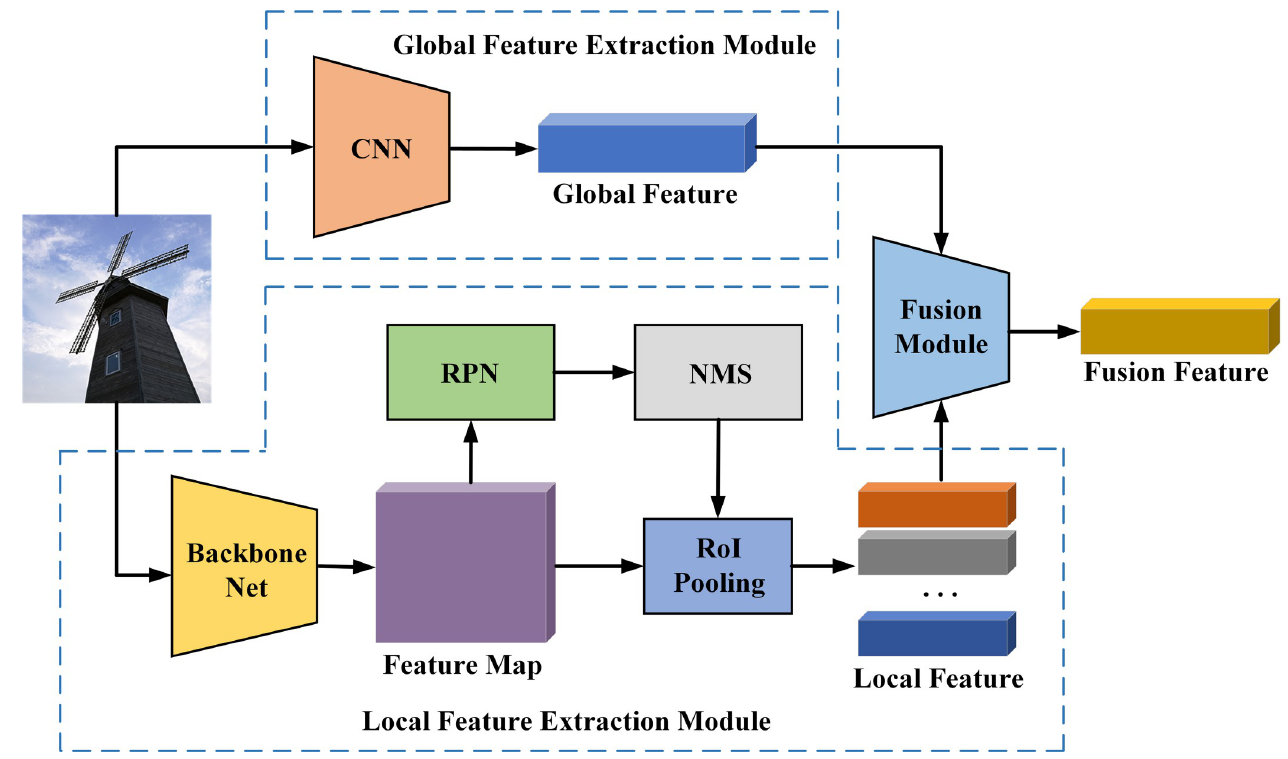
Fig 2. Extraction process of global and local image